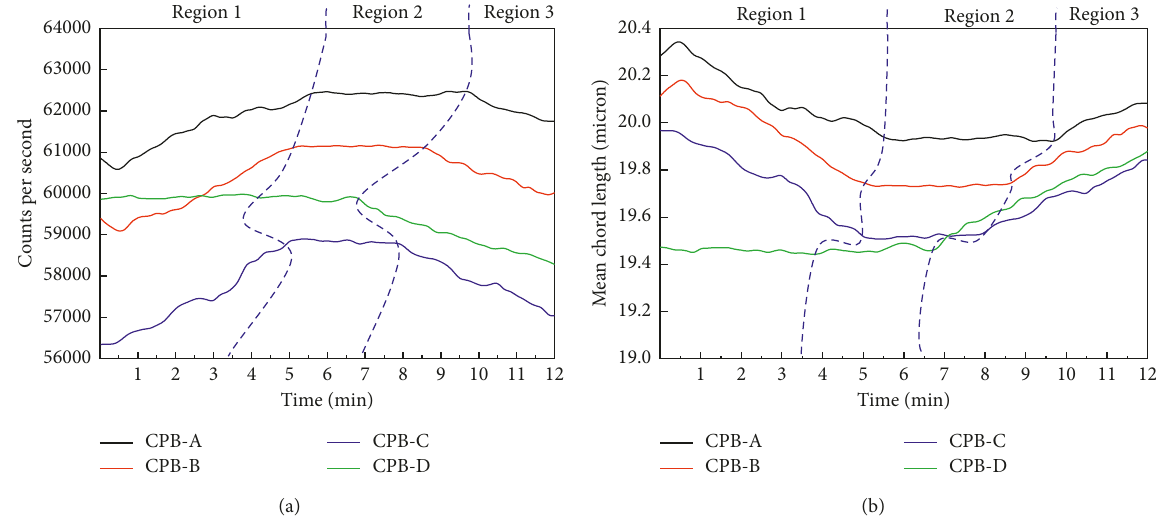
Figure 6: Influence of shear on microstructural of CPB depending on different